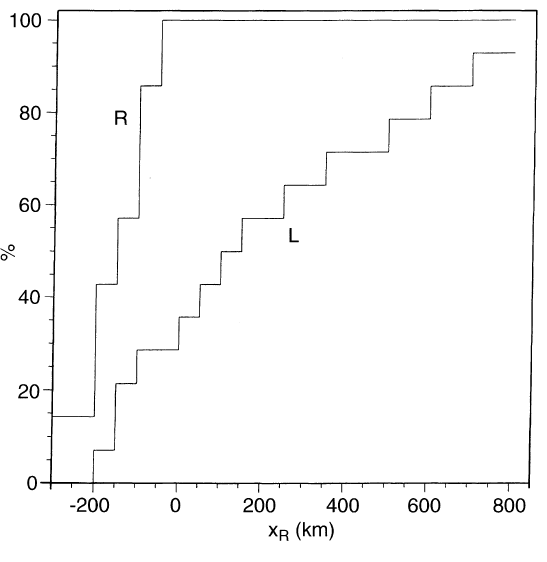
Fig. 5. Distribution of the polarization of pulsations